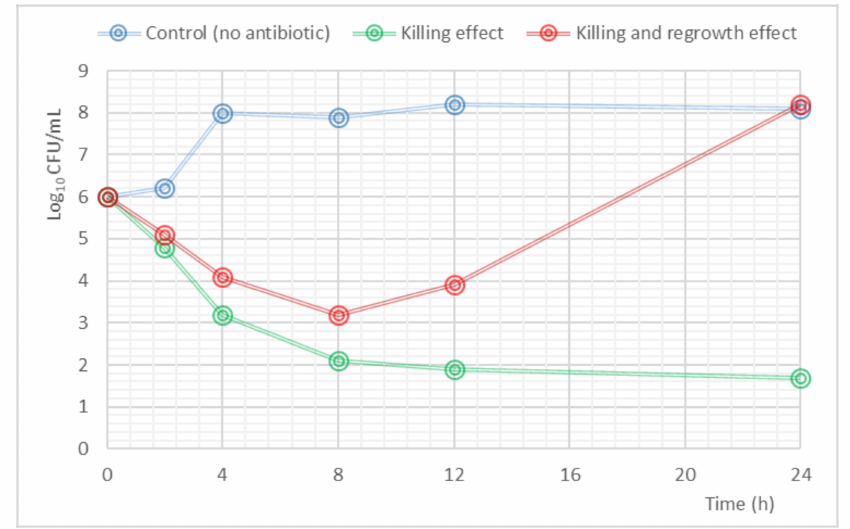
Figure 3. Example of a time-kill curve. The blue line shows the evolution of the initial inoculum in the absence of antibiotic (control); the green line represents the reduction in the bacterial count in the presence of antibiotic (killing effect); the red line explains the behavior in the bacterial load when a regrowth effect